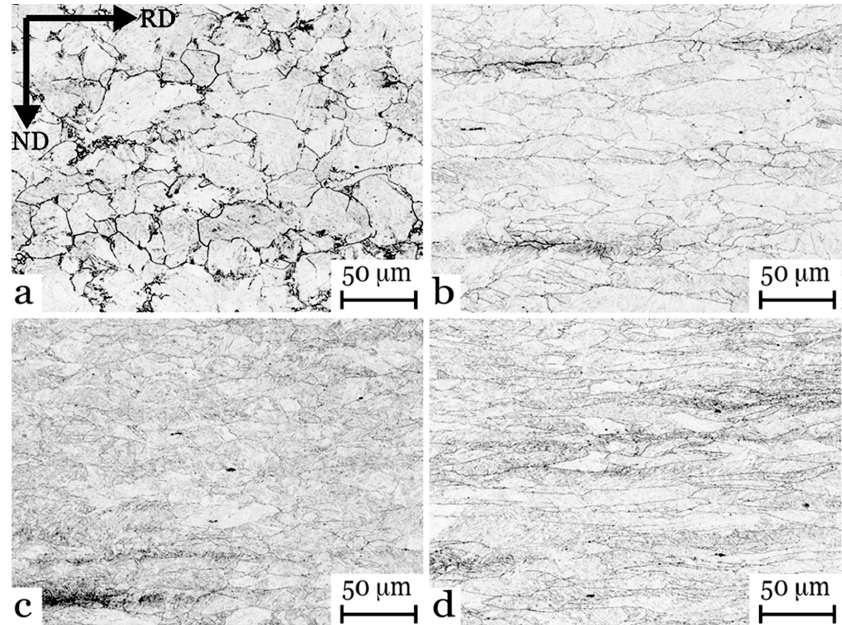
Figure 1. Prior austenite grain boundaries of the investigated steels with finish rolling temperature (FRT) of 900 °C: ( a ) 0Mo, ( b ) 0.25Mo, ( c ) 0.5Mo, and ( d ) 0.25Mo–Nb. RD = rolling direction, ND = normal direction.